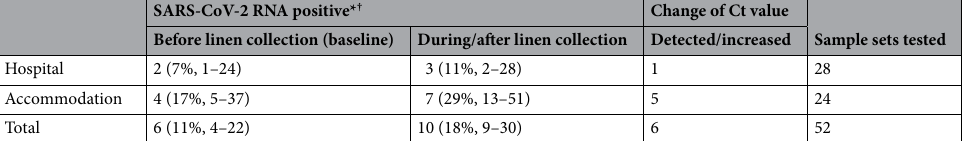
Table 4. SARS-CoV-2 test results of air samples collected before and during/after changing linens. *All Ct values detected were ≥ 36. The viral isolation result was negative. † The number of positive samples (percentage of positive samples, 95% confidence intervals for the percentages). Fisher’s exact test showed no significant difference in the RNA detection rate of air samples before and during/after linen exchange (p = 0.42) and between the accommodation and hospital (p = 0.06).